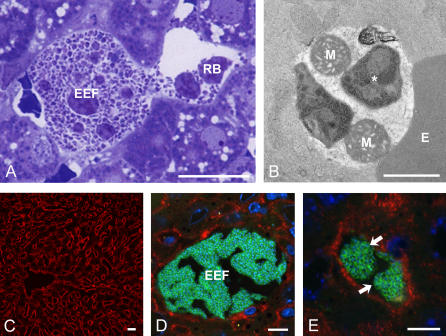
Merosomes Contain Viable Merozoites and Host Cell Organelles(A) Semithin section showing an EEF releasing a merosome into a sinusoid. Note that remnant bodies are a normal component of the merosomal cytoplasm. RB, remnant bodies. Bar = 10 μm.(B) Electron microscopy documents that merosomes contain well-preserved merozoites and hepatocyte mitochondria. E, erythrocyte; M, hepatocyte mitochondria; *, merozoite. Bar = 1 μm.(C) Immunolabeling of frozen liver sections for ASGR-1 reveals the presence of the receptor on the basolateral portion of the membrane of all hepatocytes (red). Bar = 20 μm. Neither EEFs (D) nor merosomes (E, arrows) express ASGR-1 on their surface. The merozoites were visualized with Hoechst (blue) and an antibody against MSP-1 in combination with PA-FITC (green). Bars = 10 μm.